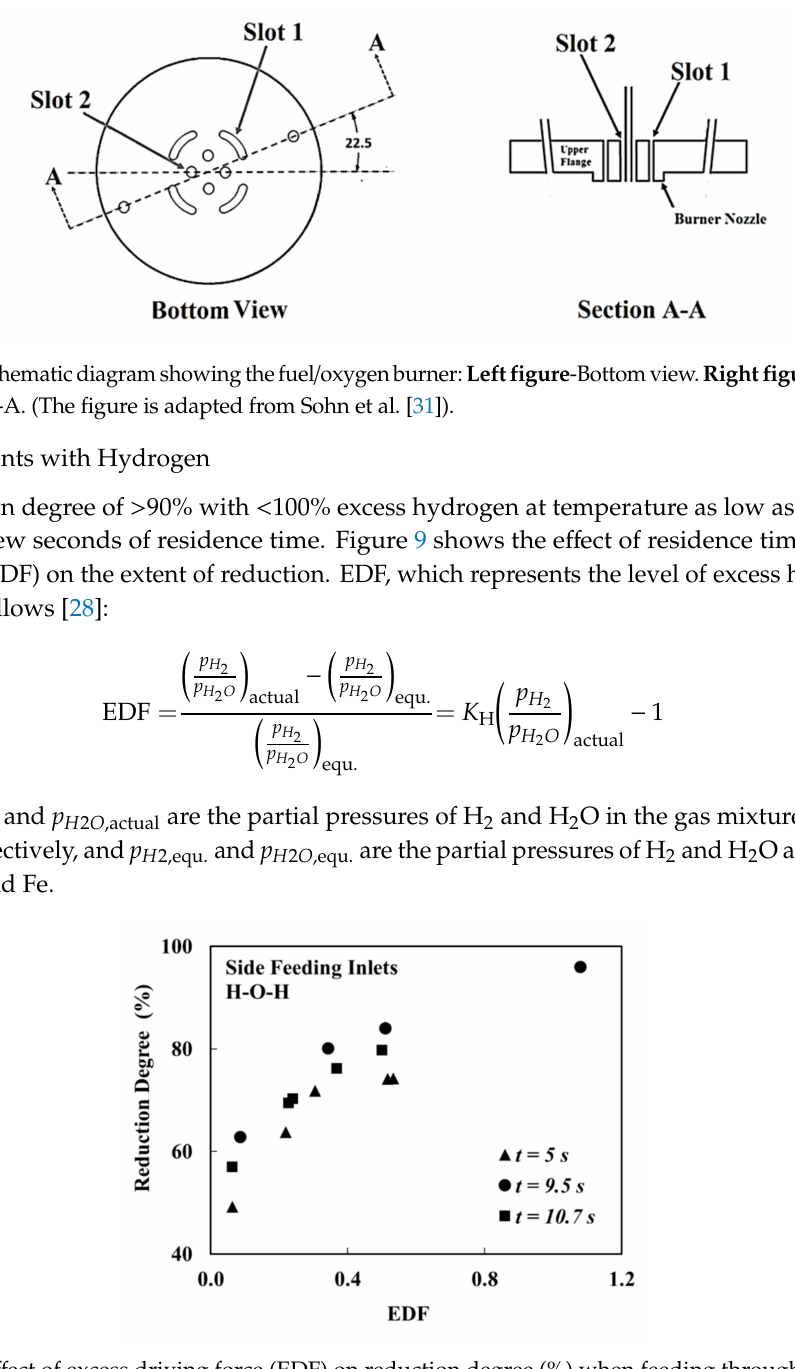
Figure 9. E ff ect of excess driving force (EDF) on reduction degree (%) when feeding through the two side-ports with the H-O-H configuration